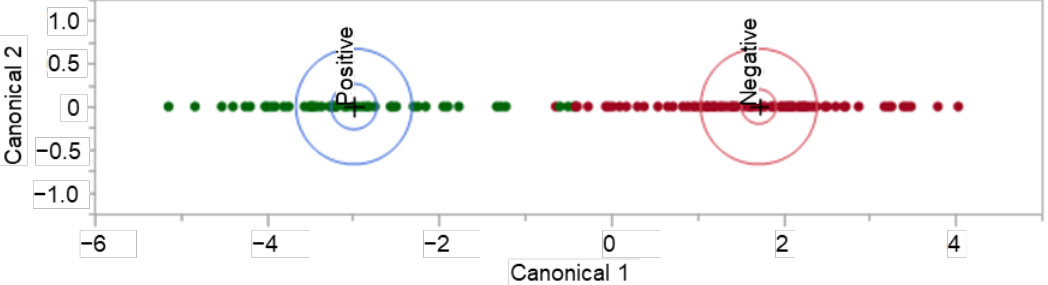
Figure 5. COVID T-shirt LDA model and model performance.